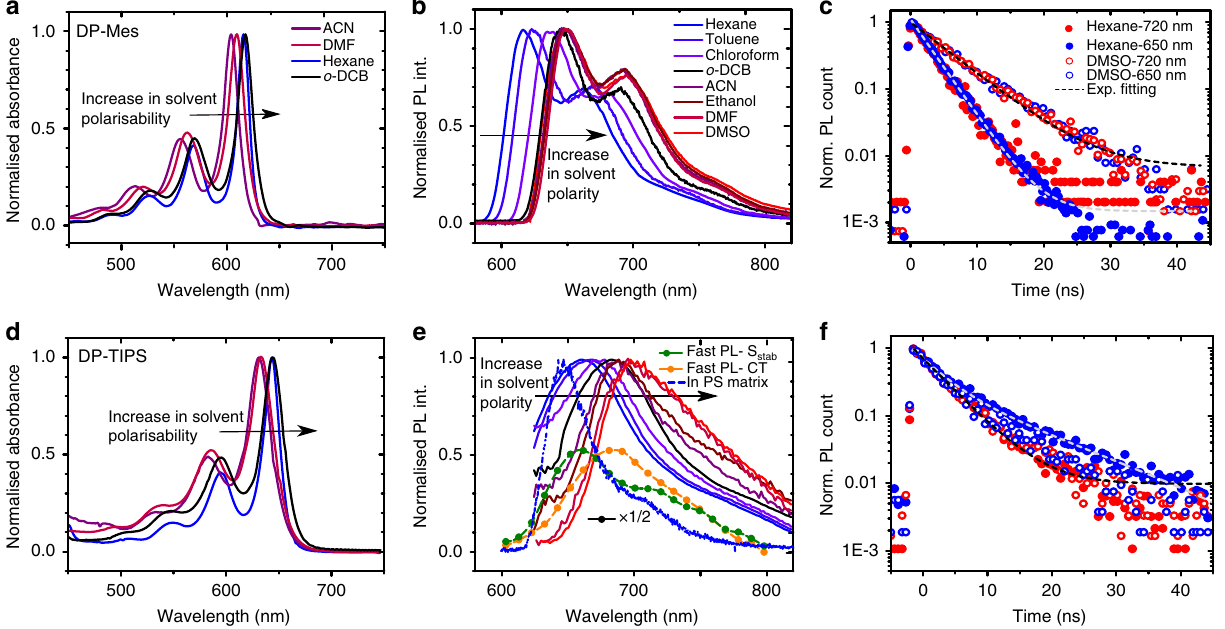
Figure 2 | Solvent-dependent absorption and emission. ( a ) DP-Mes and ( d ) DP-TIPS absorption in solvents spanning polarity and polarisability range. PL spectra of ( b ) DP-Mes and ( e ) DP-TIPS exhibit pronounced polarity dependence. Dashed line in ( e ) shows significant reduction in Stokes shift in rigid polystyrene matrix. Symbols are S stab and CTspectra extracted from a separate ultrafast PL experiment, in the first 3ps following photoexcitation in o -DCB. ( c ) DP-Mes PL kinetics show uniform decay across the spectrum in non-polar and polar solvents. ( f ) DP-TIPS kinetics show spectrally-variant lifetimes in hexane (filled circles) indicating the presence of multiple emissive species. Uniform decay is observed in highly polar DMSO (open circles). Absorption spectra and PL kinetics for other solvents shown in Supplementary Figs 1 and 3–9. Legends are the same for top and bottom